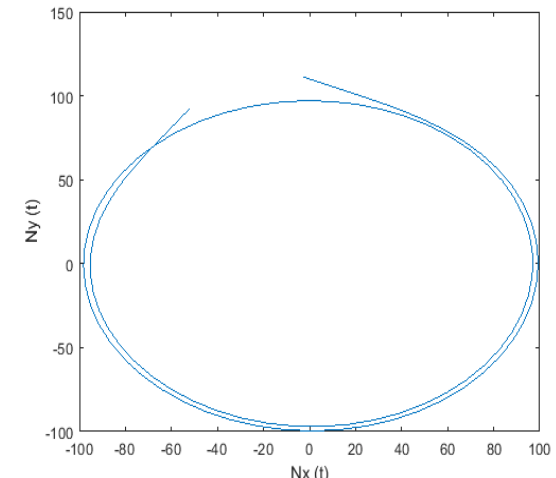
Figure 14. Numerical solutions of the Bloch equation in the plane (𝑁 (cid:3051) vs. 𝑁 (cid:3052) ) with parameters: 𝛼 = 1, 𝛽 = 1, 𝛾 = 0.9 , 𝑤 (cid:2868) = 12 , 𝑇 (cid:2869) = 1 , 𝑇 (cid:2870) = 20, 𝑎 = 1, 𝑏 = 1 .